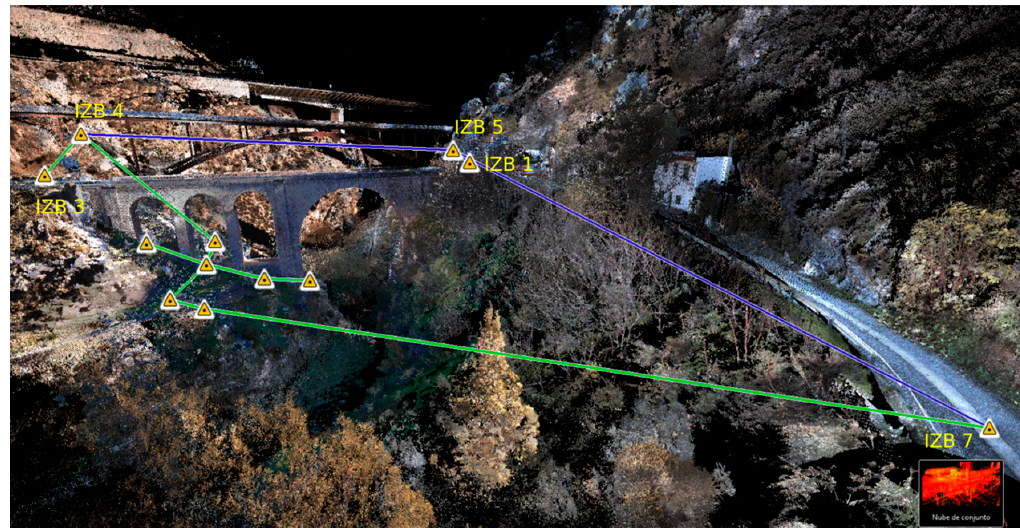
Figure 6. Scan stations ground distribution and the links between them (Point cloud) .